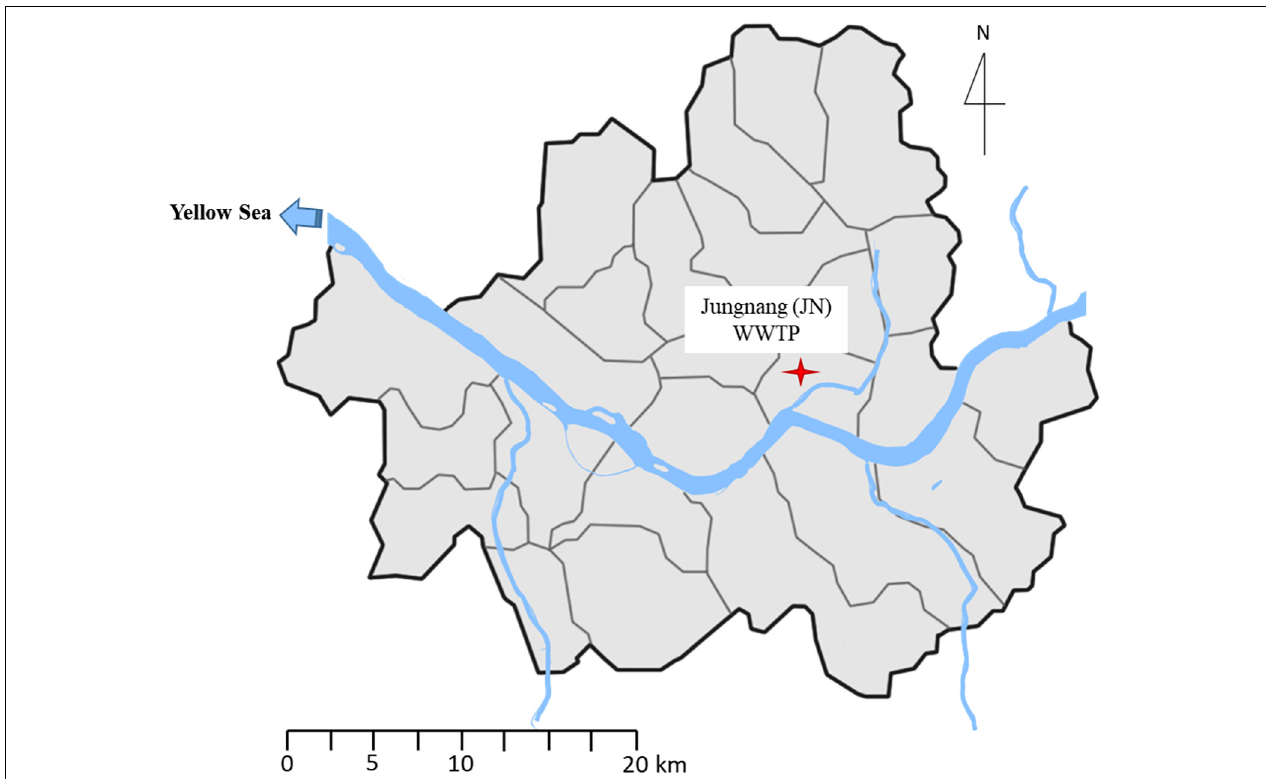
FIGURE 1 | Location of Jungnang JN Wastewater treatment plant (WWTP) on the Han River, Seoul, South